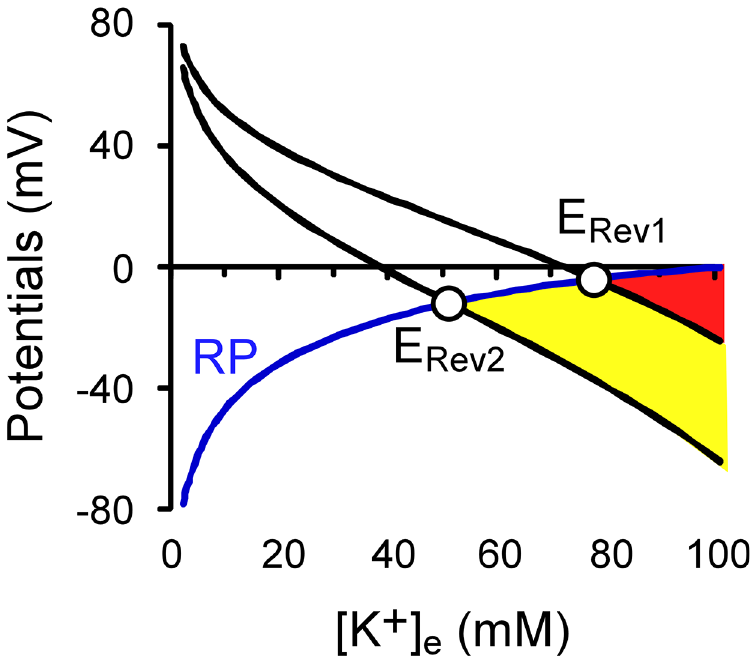
Fig 8. Reversal potential of GLT-1 transport during simulated ischemia depends on GTS. The resting potential (RP) depolarizes when extracellular potassium concentration rises during modeled ischemia. When GLT-1 reversal potential either with only one glutamate molecule transported per cycle (E Rev1 ), or when the 2 nd glutamate molecule is transported per cycle with 50% probability (E Rev2 ) are more positive than the RP, the transporter operates in normal mode and clears extracellular glutamate. The circles show the conditions of GLT-1 transport reverse at these two different transport stoichiometries.